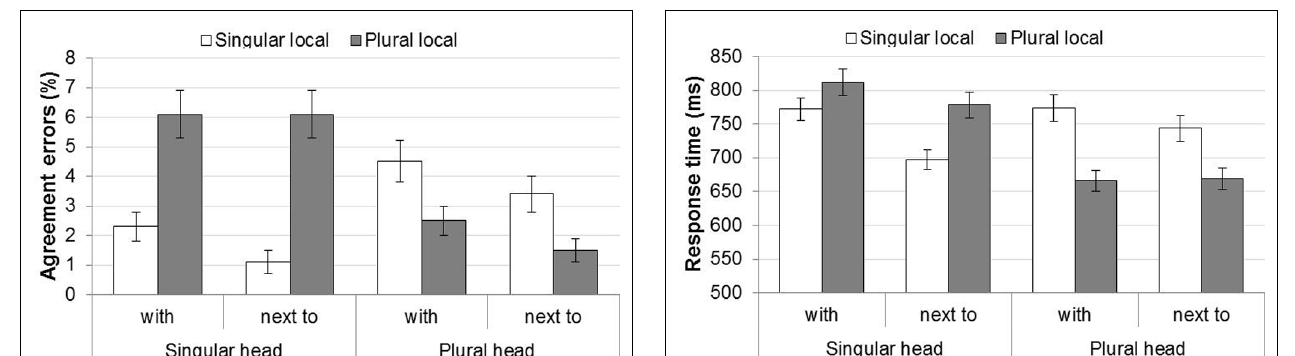
the item contained met ( M = 755 ms, SD = 517 ms) relative to when it contained naast ( M = 721 ms, SD = 494 ms). Finally,